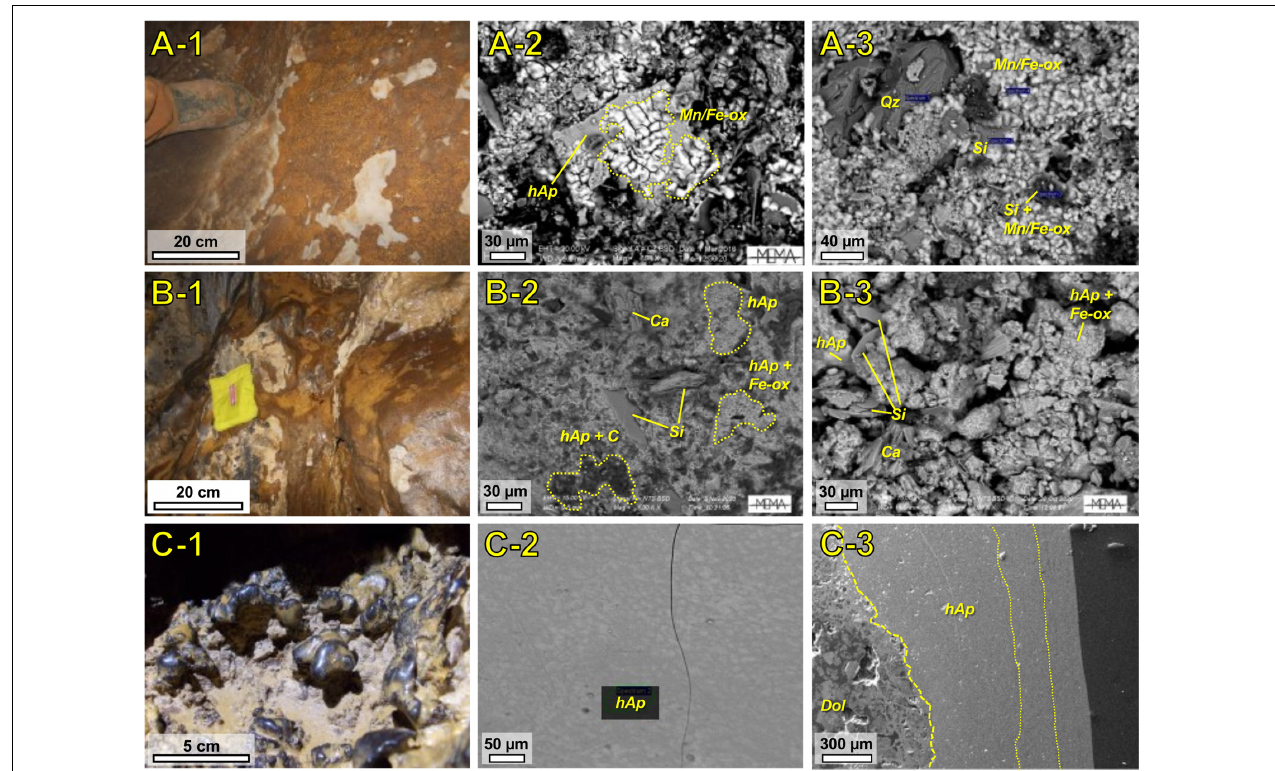
FIGURE 2 | (A-1) Brown parietal crusts on the wall of a relict phreatic passage at 1,200 m a.s.l. (A-2,A-3) SEM-BSE images of sample A-1 showing clasts of different nature (Qz = quartz, Si = silicate) covered by hydroxyapatite (hAp) and Fe/Mn incrustations (light areas, Mn/Fe-ox). (B-1) Brown parietal crusts on the wall of a relict phreatic passage at 1,400 m asl. (B-2,B-3) SEM-BSE images of sample B-1 showing clasts of different nature (Ca = calcite) cemented by apatite and Fe/Mn incrustations (light areas). (C-1) Calcium phosphate nodules on the wall of a relict phreatic passage collected in the Corchia cave at 1,200 m asl. (C-2) SEM-BSE images of sample C-1 showing its external regular surface consisting of hydroxyapatite. (C-3) Cross section of the nodule showing a regular structure roughly laminated (fine yellow dotted lines) grown on altered dolomite bedrock (yellow dashed line = bedrock/crust